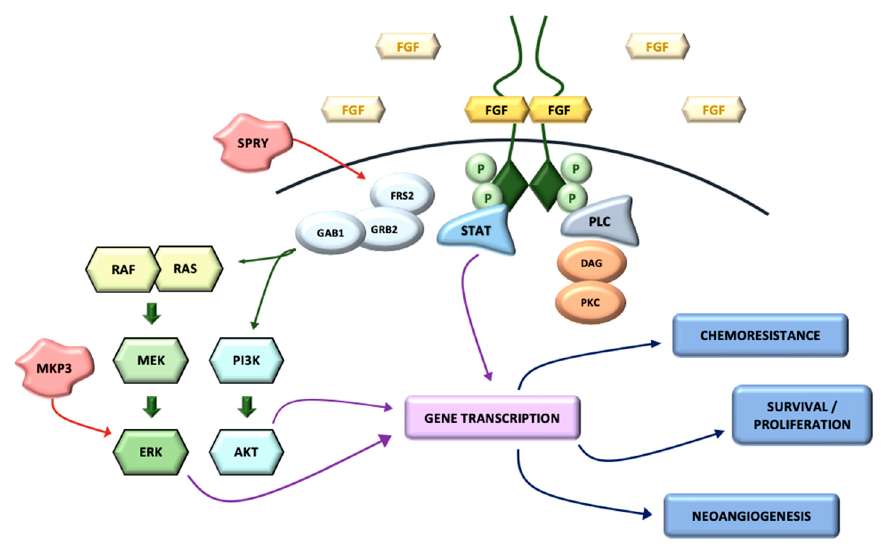
Figure 2. FGFR signaling pathway.